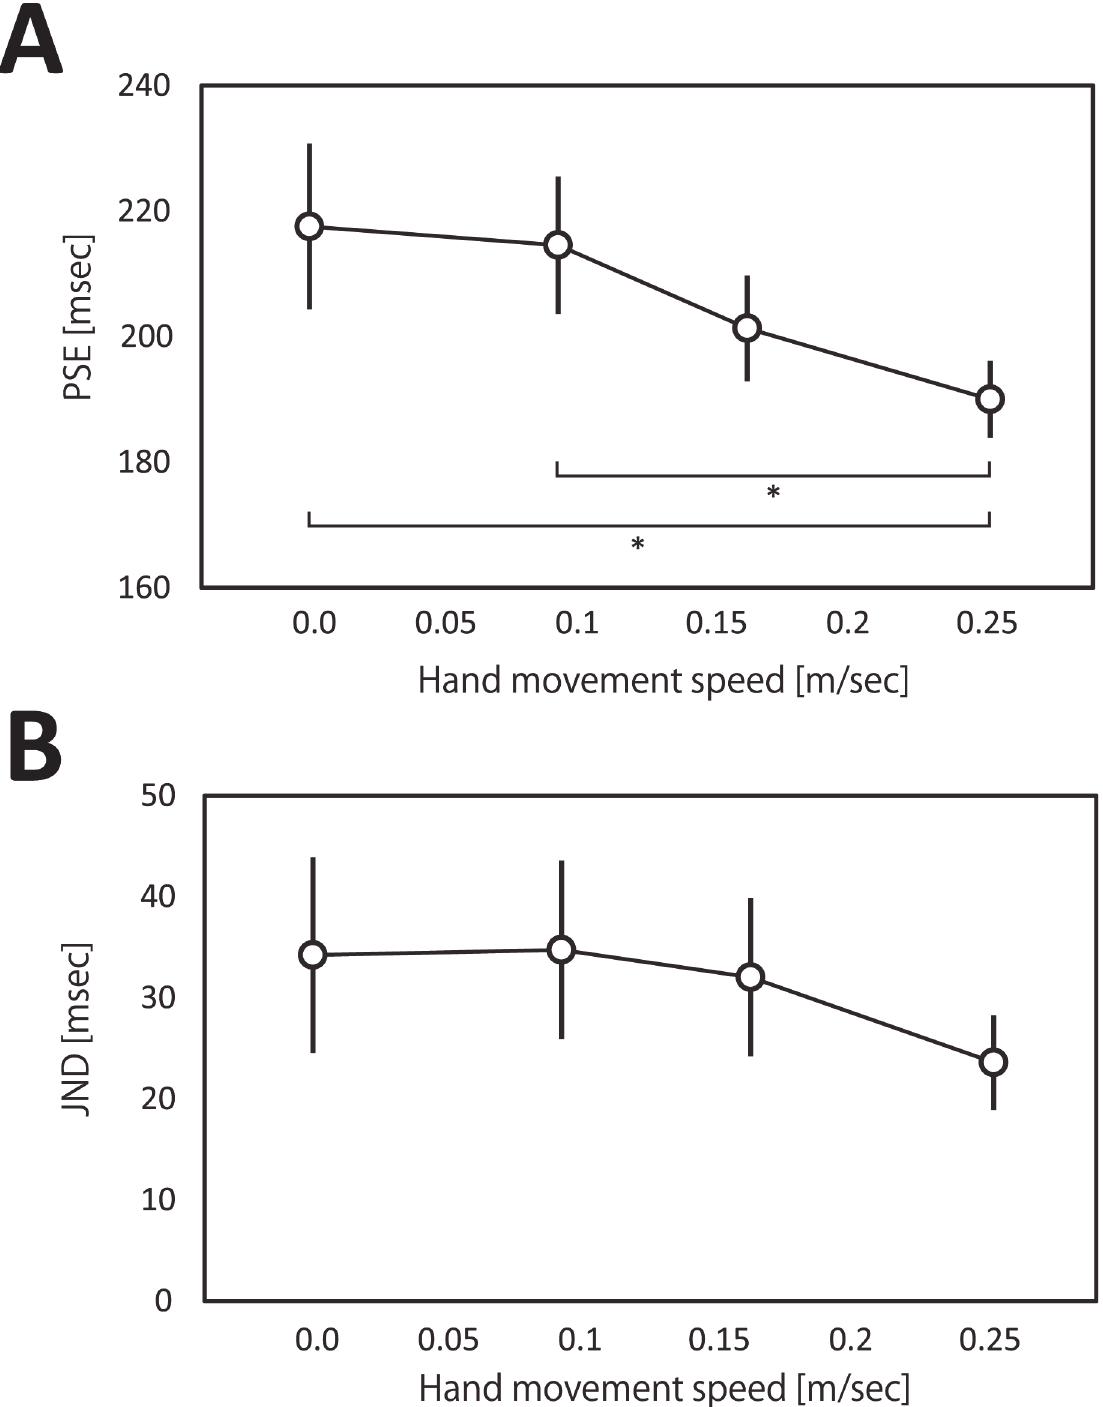
Fig 3. The results in the main experiment (n = 7). (A) The means of the PSEs. Error bars denote the standard errors. (B) The means of the JNDs. Error bars denote the standard errors.